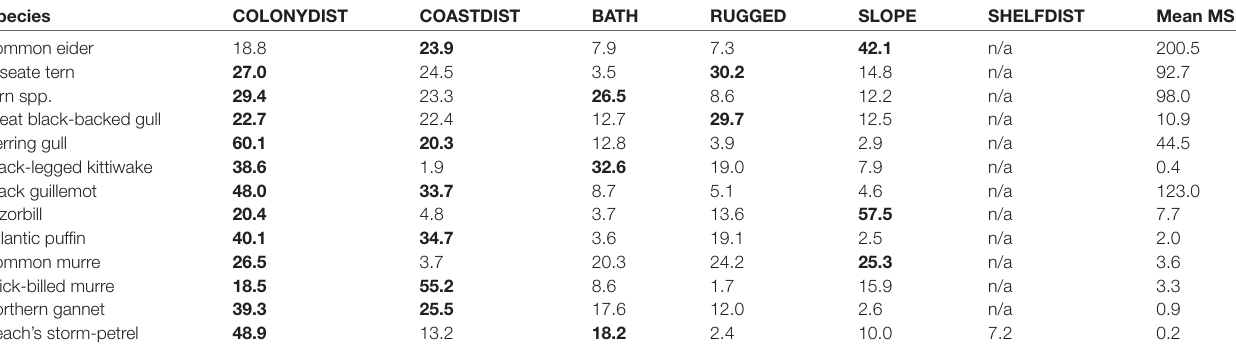
Values in bold indicated the predictor variables with the highest and second highest relative influence for each species. Mean mean-square prediction error (MSE) of relative density (RD) values (x 10 -5 ) last column. SHELFDIST was only included in the models for Leach’s Storm-petrel (see Methods). n/a = not